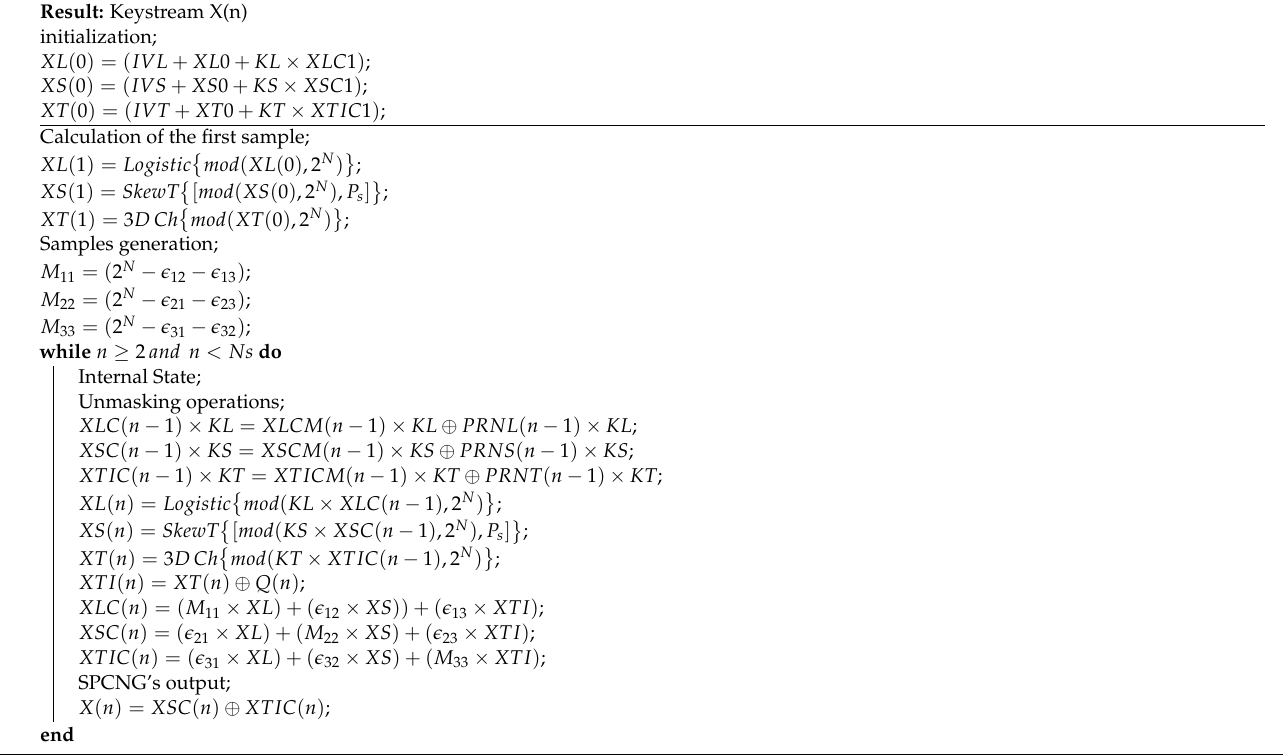
Algorithm 1: Generation of the pseudo-chaotic sequence